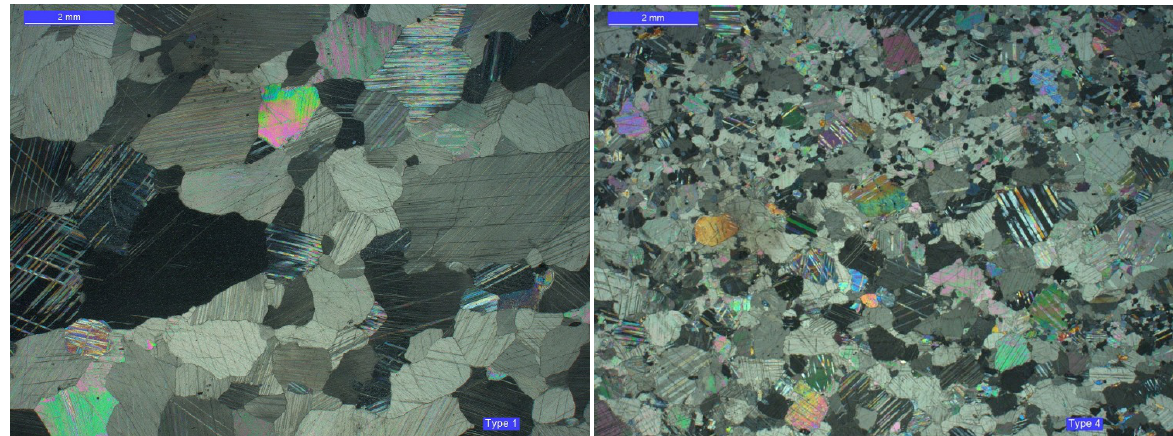
Figure 6: Magnified views of Type 1 marble on the left and Type 4 marble on the right, viewed under polarized light using a petrographic microscope. The images are shown at the same magnification scale, indicating much finer, more interlocked grain texture of Type 4 as com- pared with the larger, smoother crystals of Type 1.